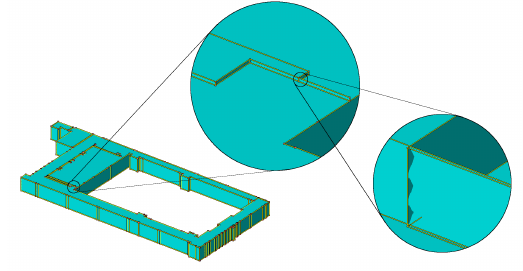
Figure 3. Self-intersecting ring in a complex geometry item, present in both original IFC and generated CityGML Some errors could not be identified and traced to a source. They actually might be false positives caused by inappropriate sensi- orientation errors for very tiny wedge-shaped profiled extru- sions, even though the geometry appears to be error-free on visual